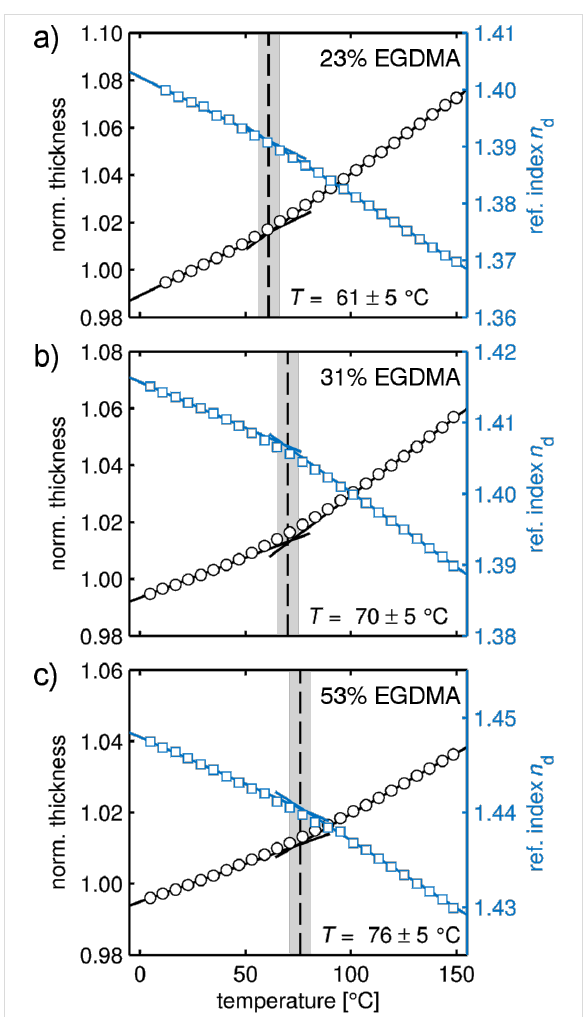
Figure 7: Normalized film thickness and the refractive index n d (at λ = 589.3 nm) as a function of the temperature for p-(PFDA- co - EGDMA) films with (a) 23% EGDMA, (b) 31% EGDMA, and (c) 53% EGDMA content. From the intersection of the linear functions fitted to the data, the thermal transitions are evidenced. The corresponding transition temperatures are annotated in the graph. The shaded area represents the error bar.